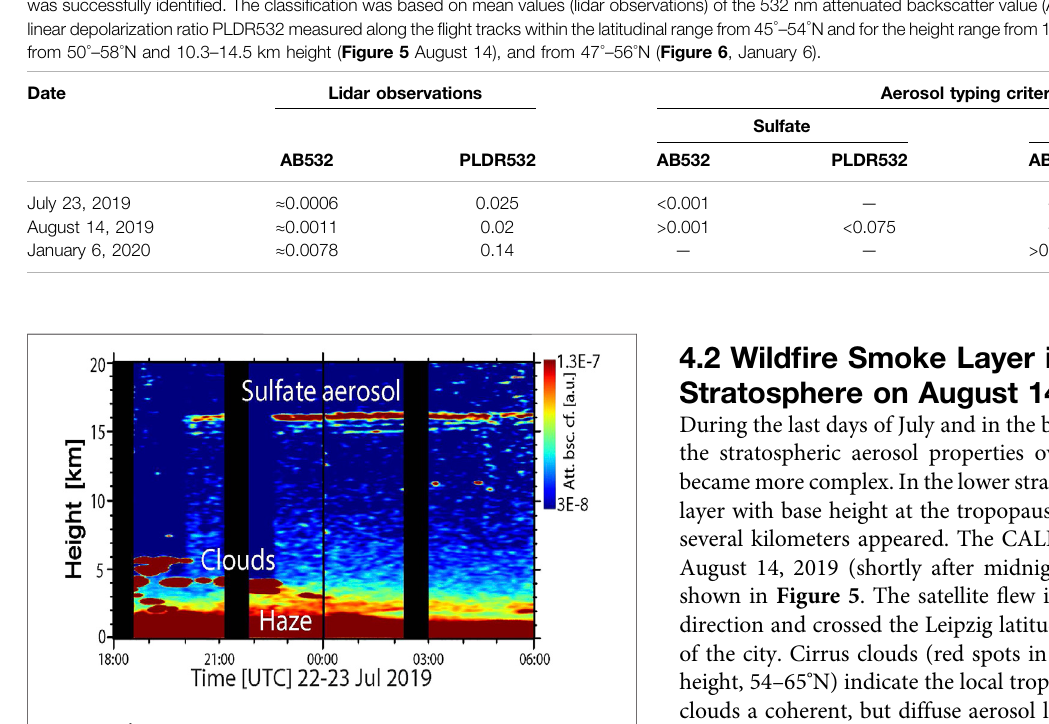
FIGURE 3 | Stratospheric sulfate aerosol layer at 15 – 17 km height measured with ground-based lidar over Leipzig, Germany, on July 22 – 23, 2019. Anthropogenic haze prevailed in the lowermost 3 km. The attenuated backscatter coef fi cient at 1,064 nm (in arbitrary units) is shown. Black columns indicate missing observations (lidar calibration